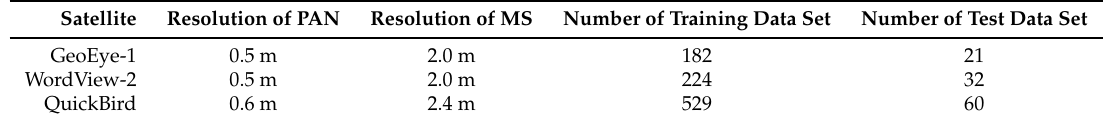
Table 1. Information of the three data